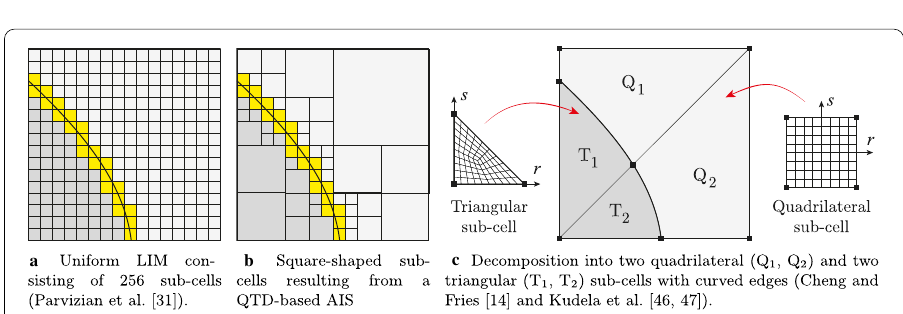
Fig. 4 Different ways of creating a local integration mesh for a two-dimensional cut cell. For sake of simplicity, the local coordinate system is not